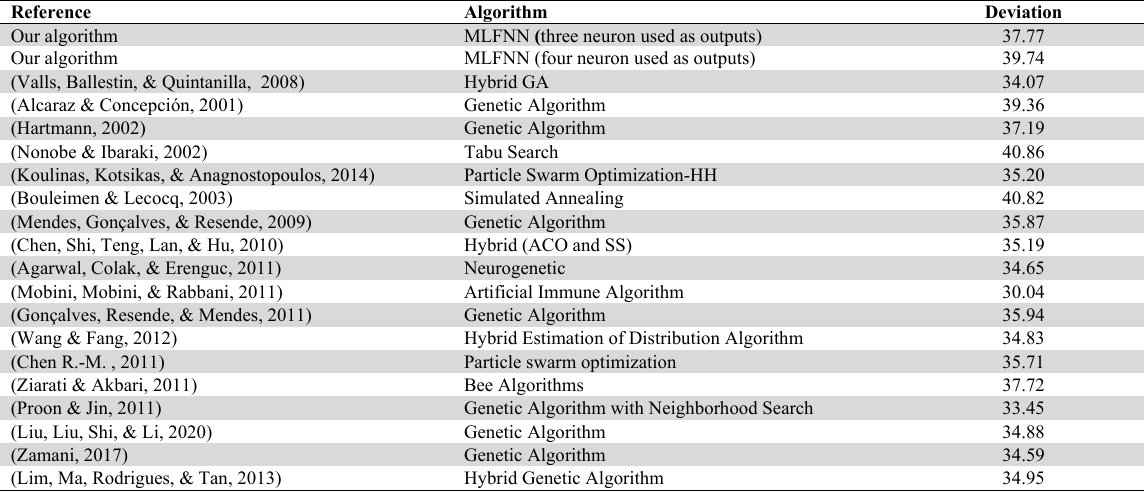
Table 7 Percentage of average deviations from critical path lower bound for the